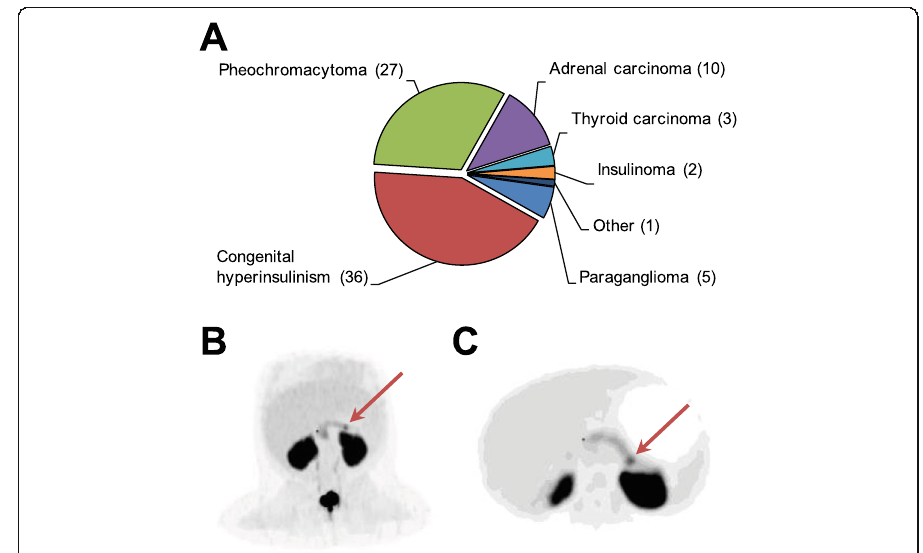
Fig. 4 Clinical data from OUH. A The composition of the subjects undergoing PET/CT scans with [ 18 F]1 from 2017 until 2020. B and C PET/CT scan of a 3.5-month-old girl suffering from congenital hyperinsulinism. ( B ) gives the maximum intensity projection while ( C ) gives the transverse plane image. The red arrows indicate the minuscule lesion with uptake of [ 18 F]1 in the cauda of